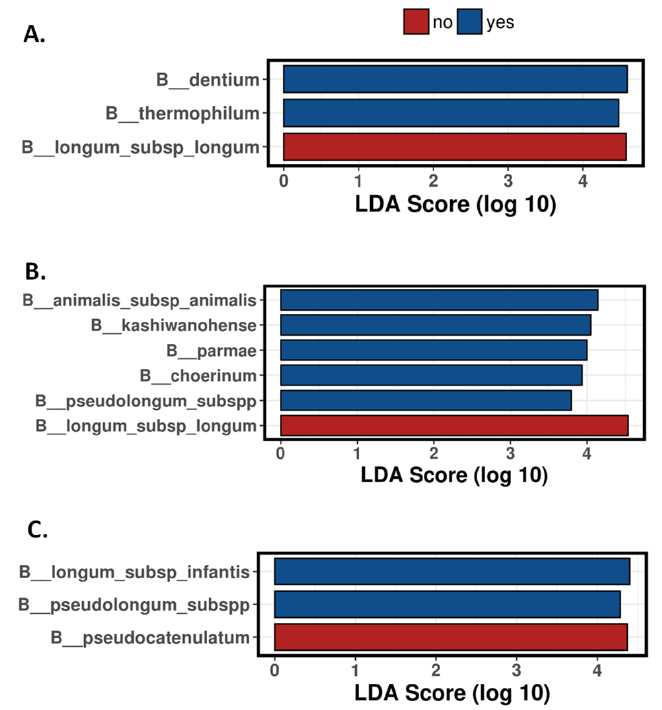
Figure 3. Bifidobacterial composition. Linear discriminant analysis (LDA) scores of bifidobacterial species with differentially abundance between antibiotic and control groups at 10 ( A ), 30 ( B ) and 90 ( C ) days of age. No: Control group (non-antibiotic); Yes: Antibiotic group.